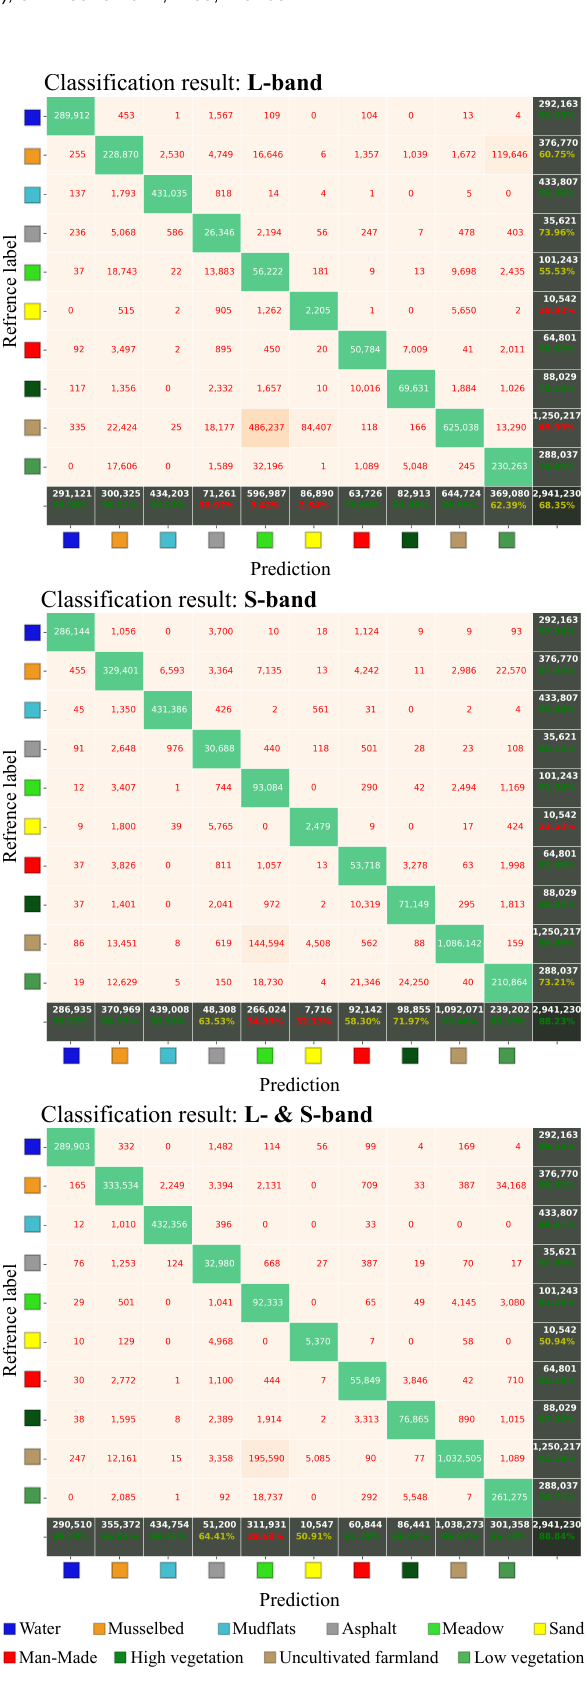
Figure 4. Confusion matrices for KNN classification